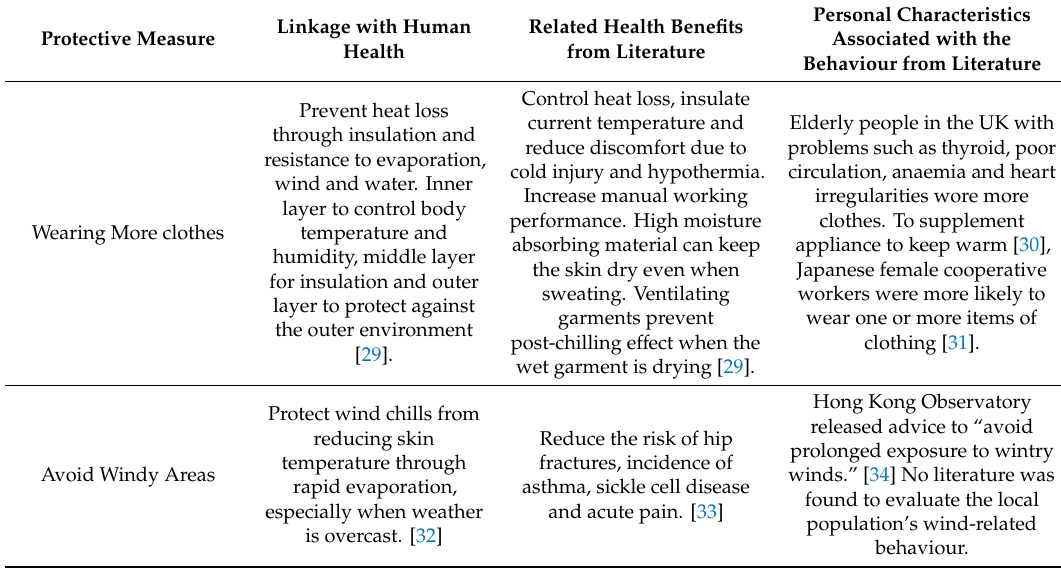
Table 1. Biological association between personal cold protective behaviours and health